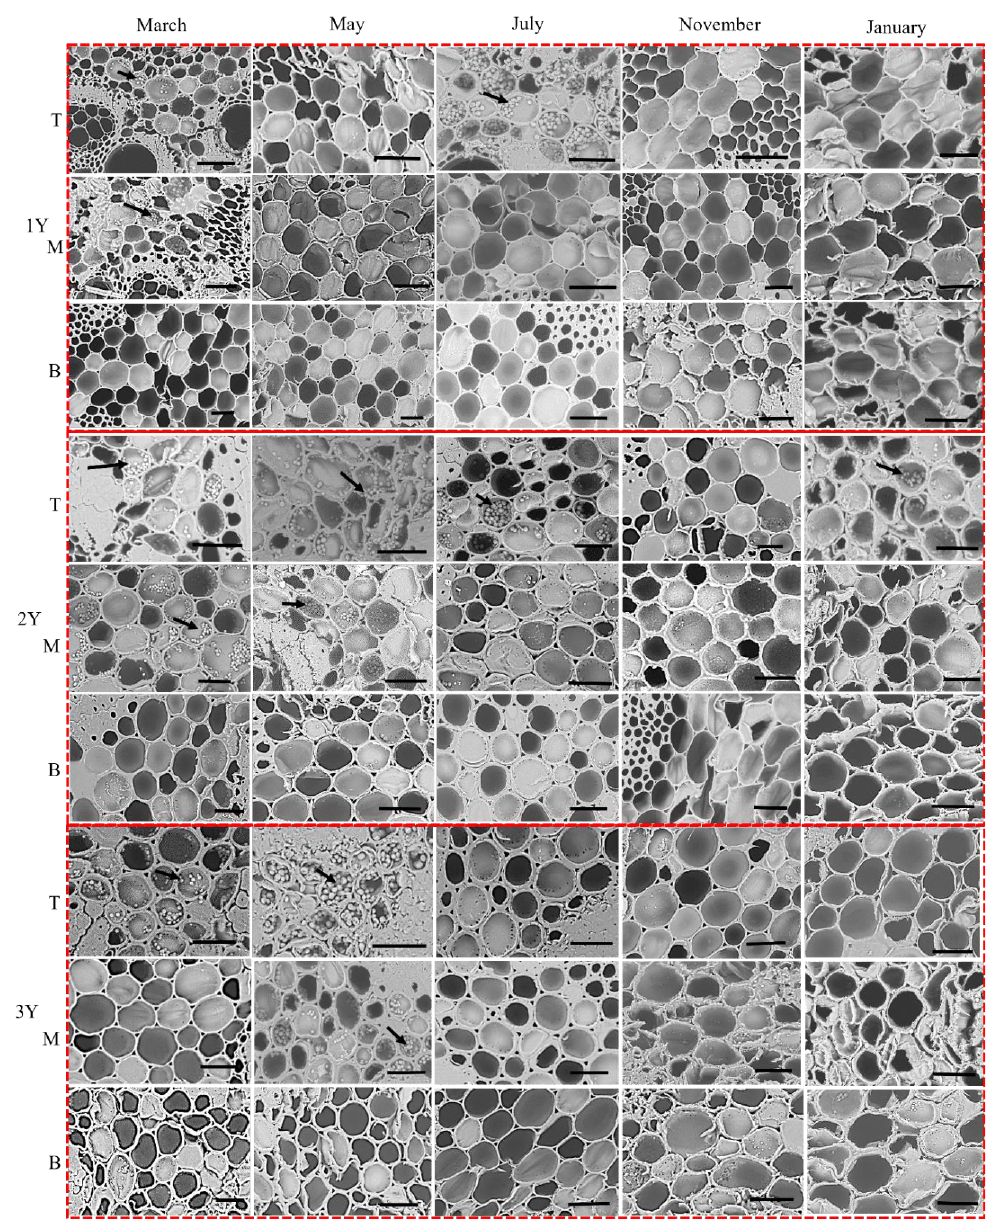
Figure 8. Starch granule distributions in Fargesia yuanjiangensis culms at different phenological stages.